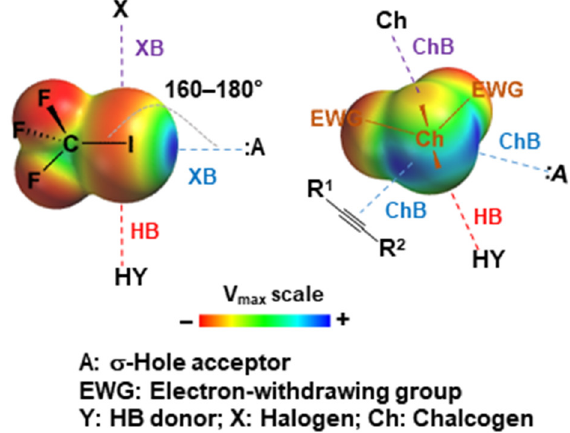
Figure 1. Halogen bond (XB) and chalcogen bond (ChB) as representative members of σ-hole inter- actions.